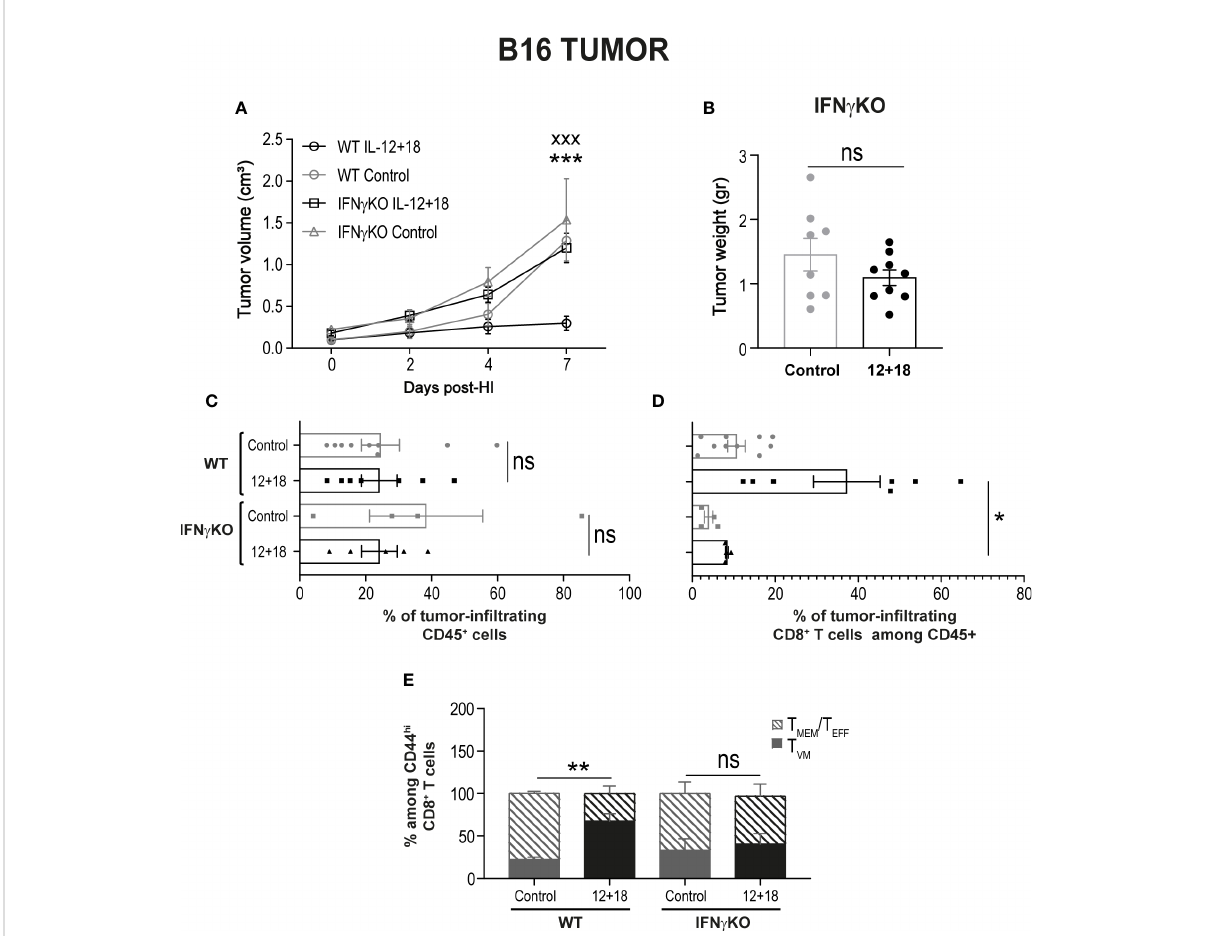
FIGURE 10 Effects of the systemic co-expression of IL-12 plus IL-18 on tumor growth on animals de fi cient on IFN g . B16- bearing C57BL/6 WT and IFN g KO mice were hydrodynamically injected (HI) with IL-12 plus IL-18 cDNA (12 + 18) or empty cDNA as the control. At the indicated times post-HI tumor size was measured using a caliper. After 7 days post-HI mice were euthanized, and tumors were harvested, weighed using an analytical scale and processed for fl ow cytometry using a Zombie dye, anti-CD45, CD8, CD44, and CD49d. (A) B16 Tumor growth represented as tumor volume (in cm 3 ) at speci fi ed days post-HI is shown as an average (mean ± SEM) for each experimental group. (B) B16 tumor weight in grams is represented as mean ± SEM for each speci fi ed experimental group. (C – E) Bar graphs represent the frequencies of (C) CD45 + in fi ltrating leukocytes, (D) CD8 + cells, or (E) T VM and T MEM /T EFF frequencies among memory CD44 hi CD8 + cells. Statistical analysis was performed using a two-way ANOVA multiple comparison test with Sidak correction on (A) , a Student T test (B) , One-way ANOVA Test (C, E) or Brown-Forsythe and Welch ANOVA test (D) as appropriate. Values of *p<0.05, **p<0.01, ***p<0.001, and xxx p<0.001 were consider signi fi cant and represent the difference between control and 12 + 18 WT mice (*), or between 12 + 18 WT and IFN g KO mice (x), respectively. Ns, Not signi fi